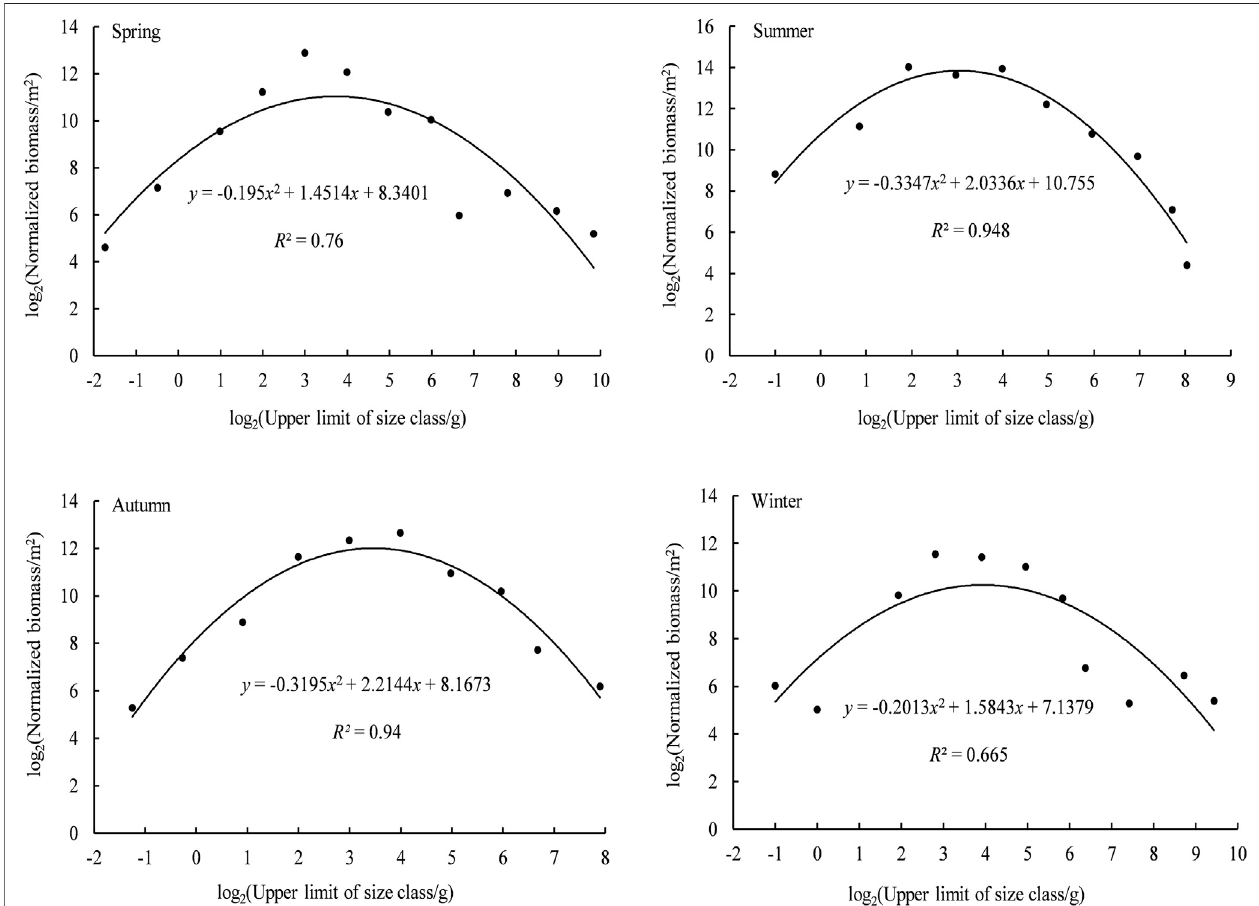
FIGURE 7 | Normalized biomass spectra of fi shes in every season in Daya Bay.